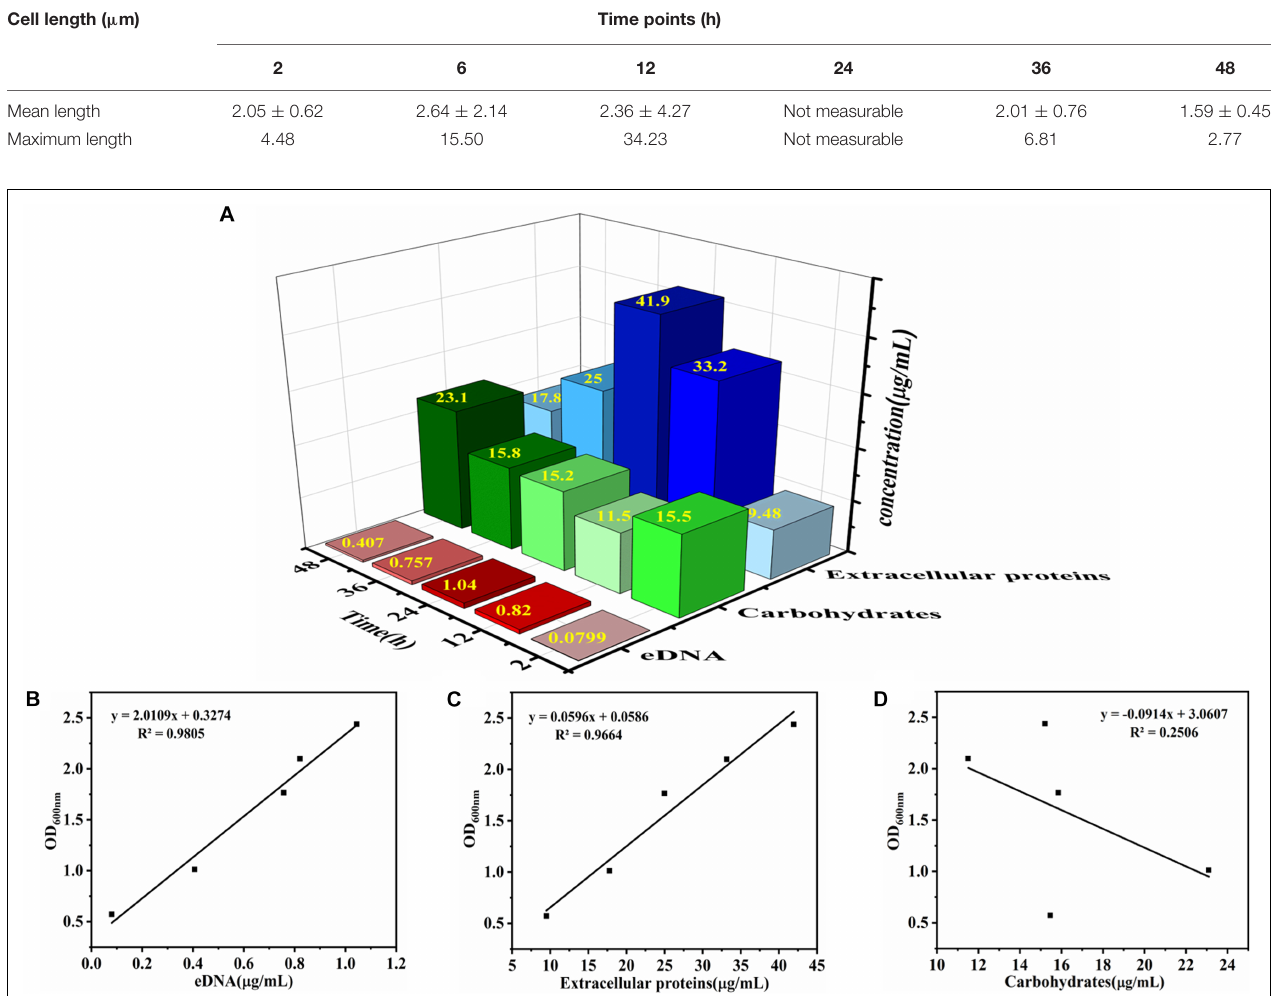
FIGURE 2 | Determination of chemical component contents in EPS and the correlation analysis between chemical component contents and V. parahaemolyticus biofilm formation. (A) The contents of eDNA, extracellular proteins, and carbohydrates in EPS were determined after 2, 6, 12, 24, 36, and 48 h of cultivation. The color of red, green, and blue represent eDNA, carbohydrates, and extracellular proteins, respectively. The intensity of the color represents the level of chemical component contents in EPS. Correlation analysis between chemical component contents in EPS and biofilm formation: (B) eDNA, (C) extracellular proteins, and (D)